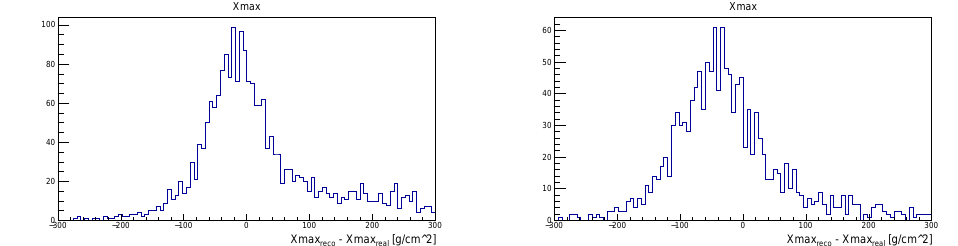
Figure 16. Estimates of X max reconstruction for 200 EeV. ( Left ): 30 ◦ zenith angle. ( Right ): 45 ◦ zenith